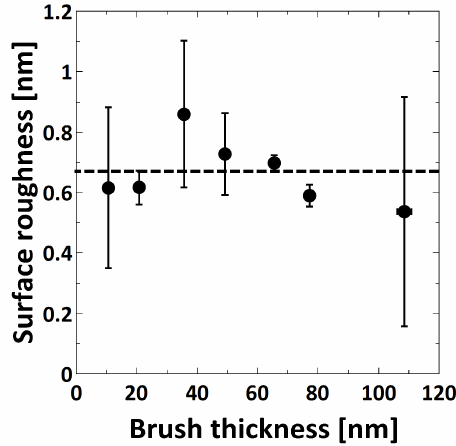
Figure 2. Surface roughness at ambient conditions (determined from atomic-force microscopy (AFM) micrographs) as a function of ambient brush thickness (as measured by